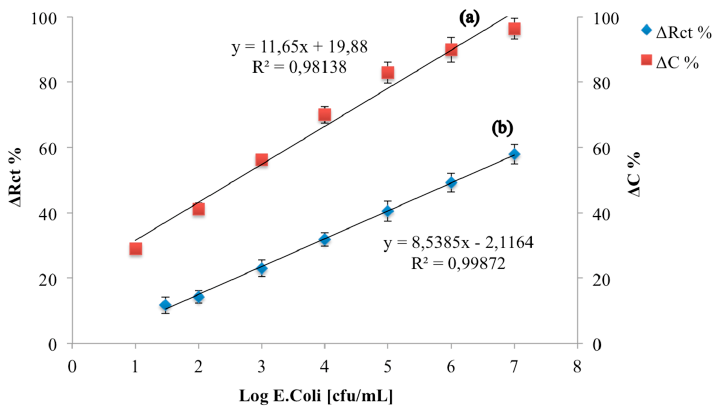
Figure 8. Calibration curves of a capacitive E. coli immunosensor ( a ) and a resistive E. coli immunosensor ( b ).